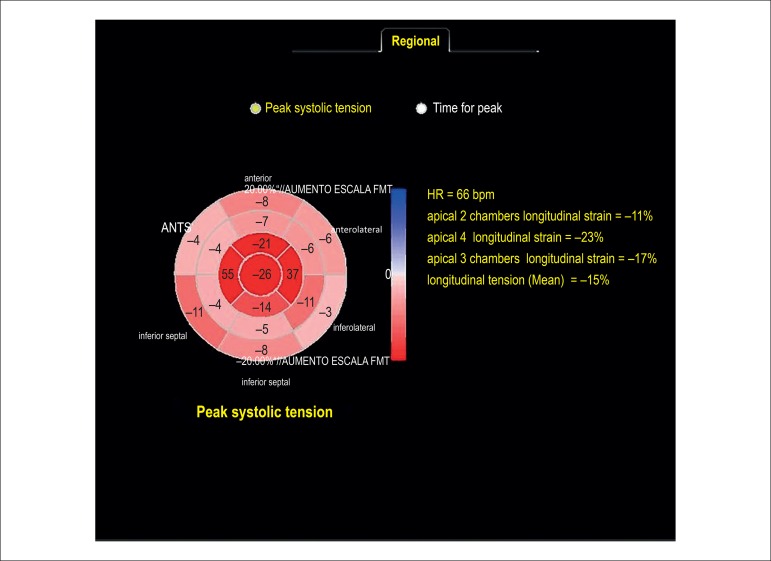
Bull's-Eye graph of cardiac amyloidosis patient. Apical longitudinal
strain is preserved and there is important decrease in basal and medial
segments.